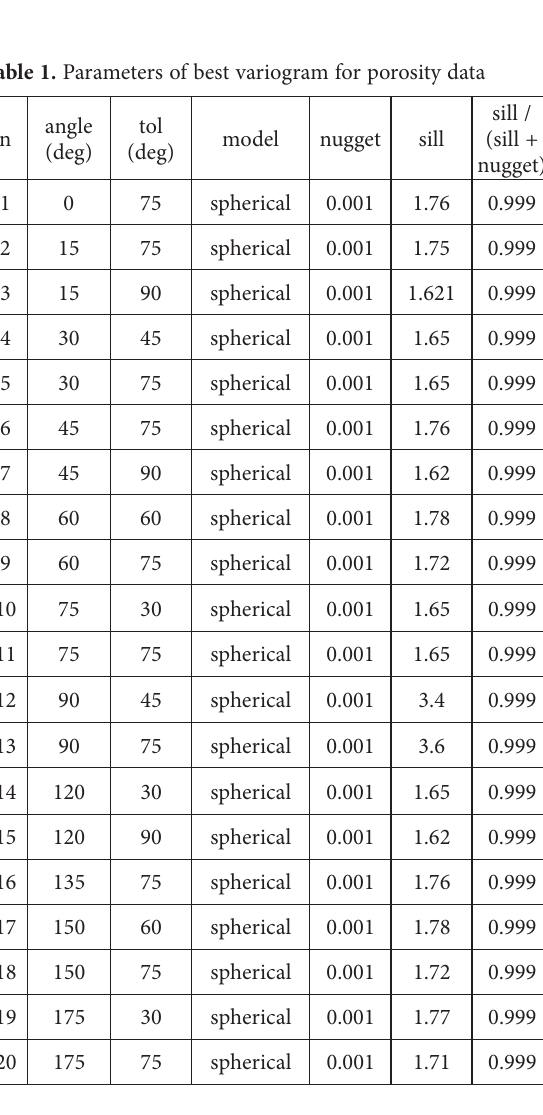
Fig. 3. Best variogram models for estimations in semivariance analysis